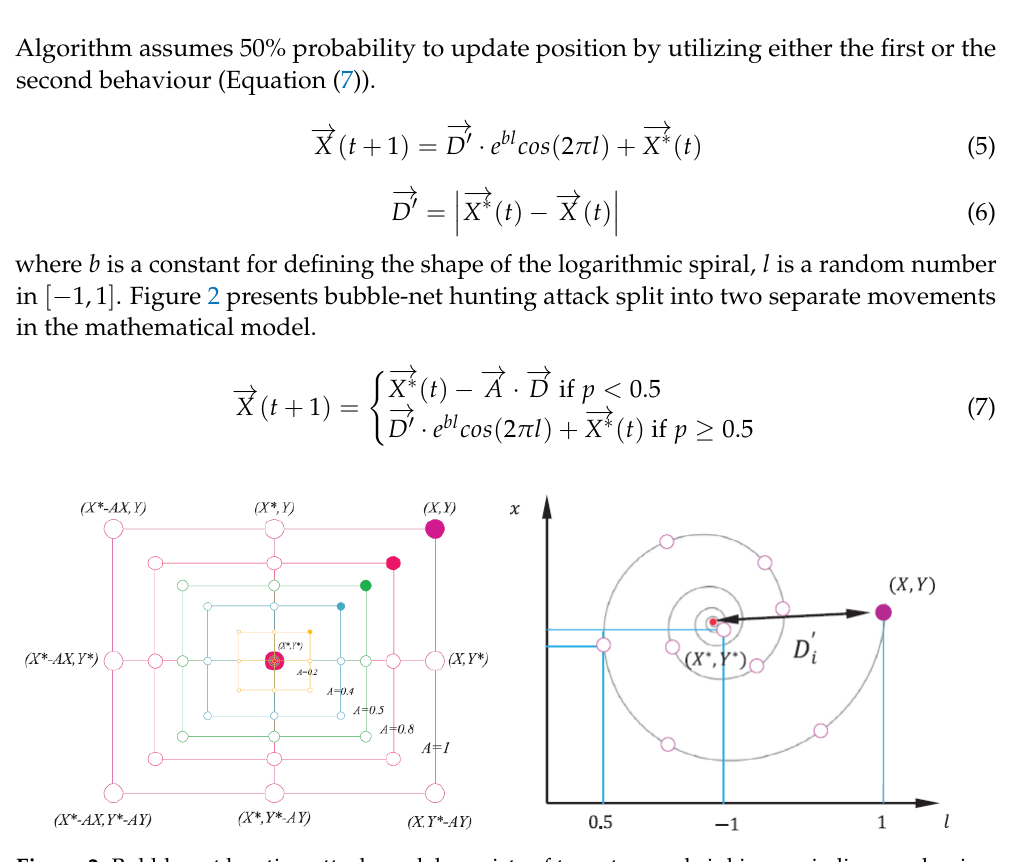
Figure 2. Bubble-net hunting attack model consists of two stages: shrinking encircling mechanism ( left ) and spiral updating position ( right ), chosen in semi-random order [8]. Reproduced with permission from Elsevier publisher, licence no.